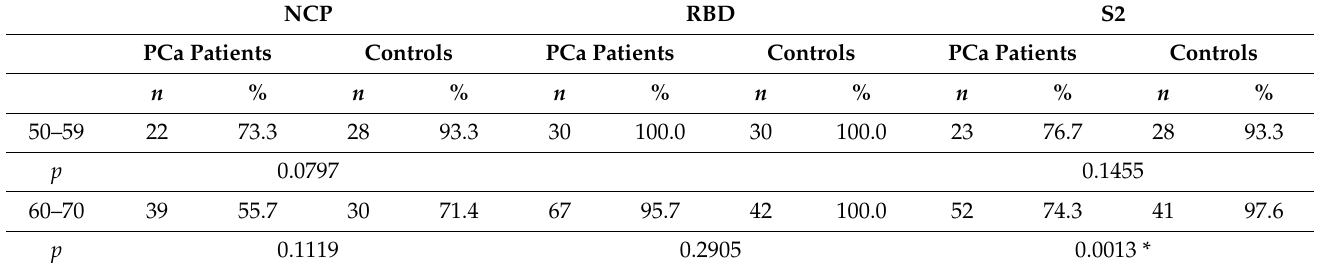
Table 2. Prevalence of NCP, RBD, and S2 IgG antibodies (U/mL) in PCa patients and controls by age.